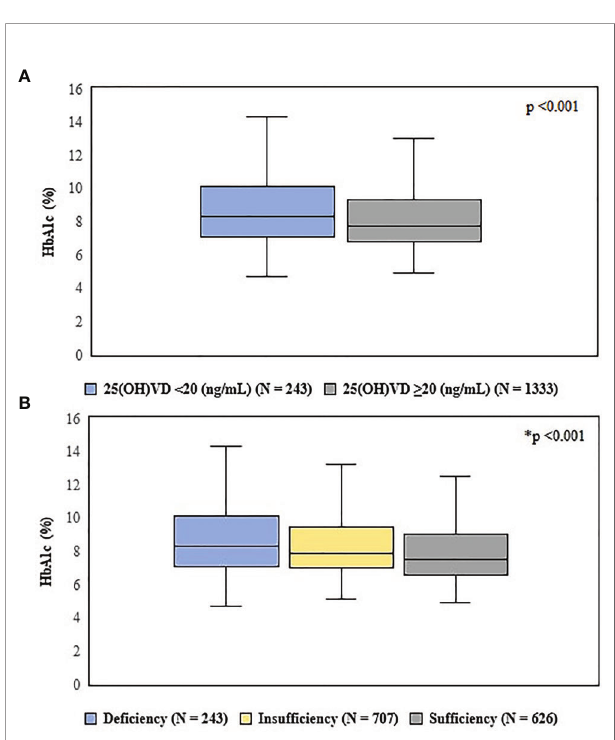
FIGURE 2 | Comparison of HbA1c levels, according to Vitamin D status. (A) = de fi ned by the 97.5 percentile, indicated by the Institute of Medicine. Statistical test used: Mann – Whitney U test. (B) = according to Endocrine Society criteria. Statistical test used: Kruskal-Wallis test. De fi ciency = 25(OH) VD<20 ng/ml; Insuf fi ciency = 25(OH)VD between 20 and 30 ng/ml; Suf fi ciency = 25(OH)VD ≥ 30 ng/ml. *p < 0.05 between all